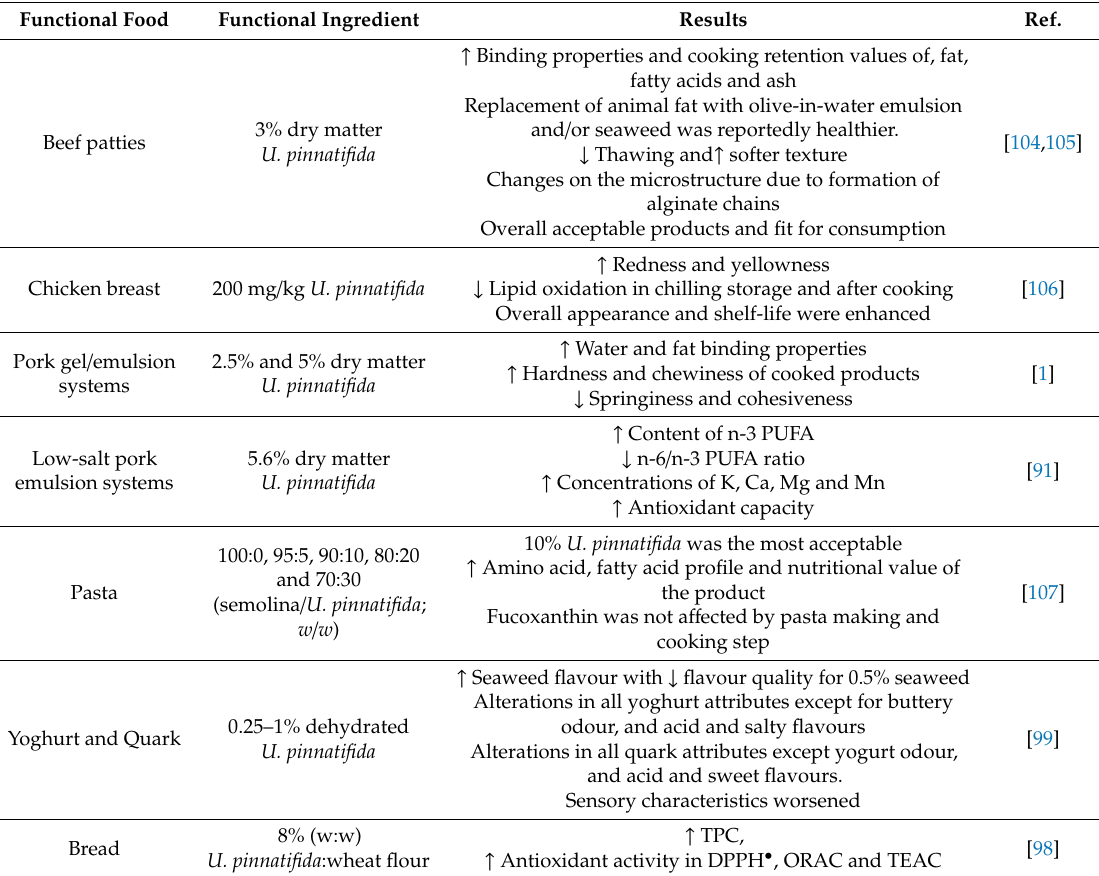
Table 3. Selected studies reporting the e ff ects of the incorporation of U. pinnatifida or isolates as ingredients in di ff erent food